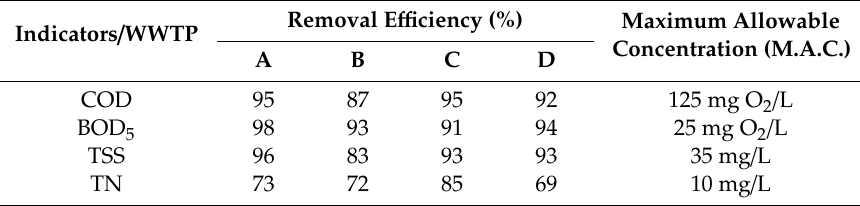
Table 3. Removal e ffi ciencies of the selected indicators and maximum concentrations for discharging in natural water